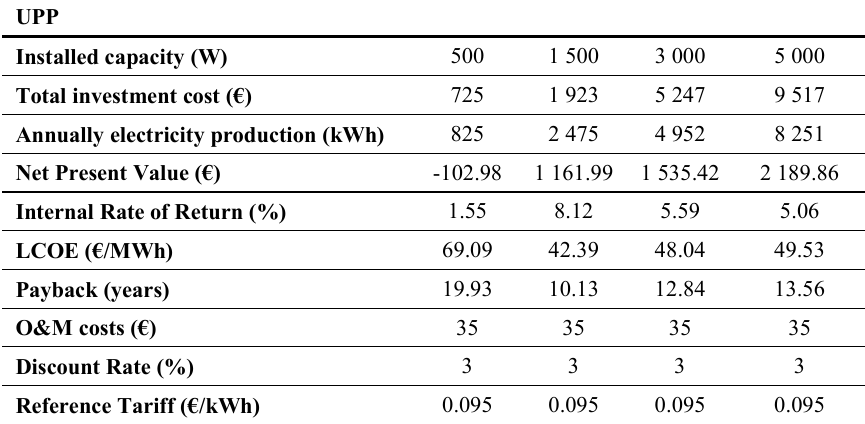
Table 1. The life span of the PV system is assumed to be 25 years. For the investment costs of both UPP and UPAC units, 250 W polycrystalline panels were considered, together with inverter, slanted roof structure, transportation Table 1. Economic analysis of different UPP